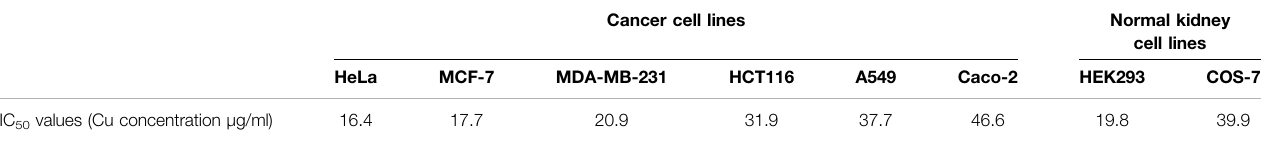
TABLE 1 | IC 50 values for six cancer and two non-tumor cell lines observed after exposure to CuS-BSA nanocrystals.